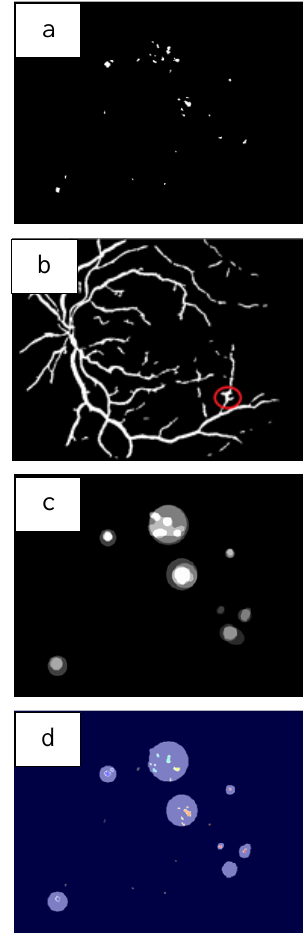
Fig. 9. (a) Final detected haemorrhages; (b) Haemorrhages coincide with retinal vessels; (c) ground truth image; (d) validation process Having gained the value of TP, and FN, the next process conducted is calculated the sensitivity value. The results of sensitivity are presented in Fig. 10. As shown in Fig. 10, we can see that the highest sensitivity value is 100.0%, while the lowest one is 16.7%. From the whole number of images, the average value of sensitivity achieved is